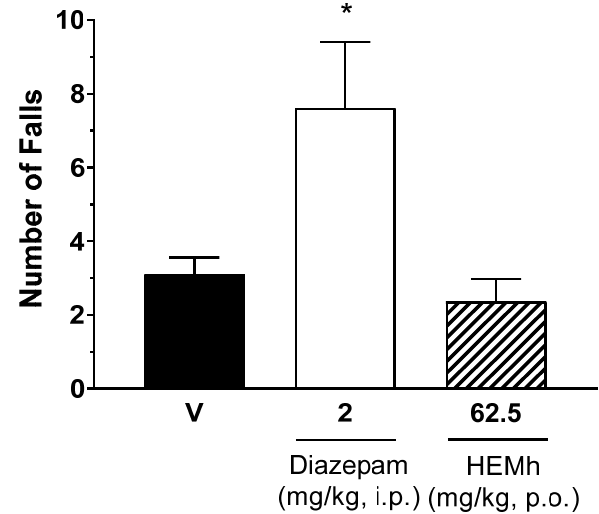
Figure 5. Effect of the hydroalcoholic extract of the twigs of Machaerium hirtum (HEMh) and diazepam (control positive) on the locomotor performance of mice in a rotarod test. The results are the number of falls in each group of animals expressed as the mean of values obtained in 8 animals per group and the vertical lines indicate the S.E.M. Statistical analyses were performed using one-way ANOVA (analysis of variance) followed by Tukey´s post hoc test (vehicle (V) vs. Diazepam * p < 0.05).